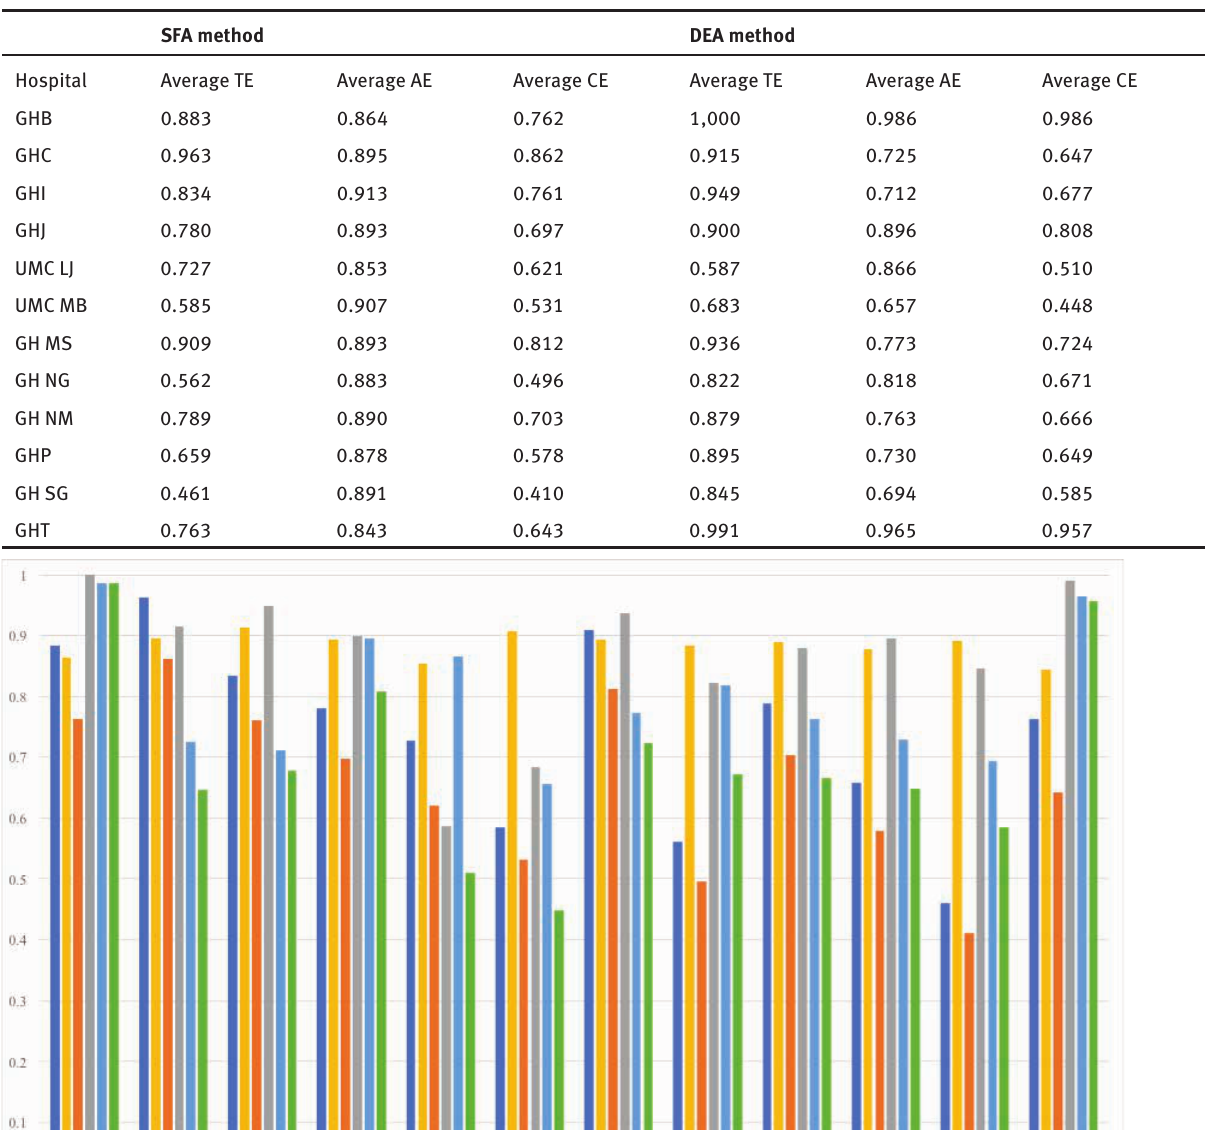
Table 1: Average values of technical, allocative and cost efficiency of general hospitals, estimated by the SFA method and DEA